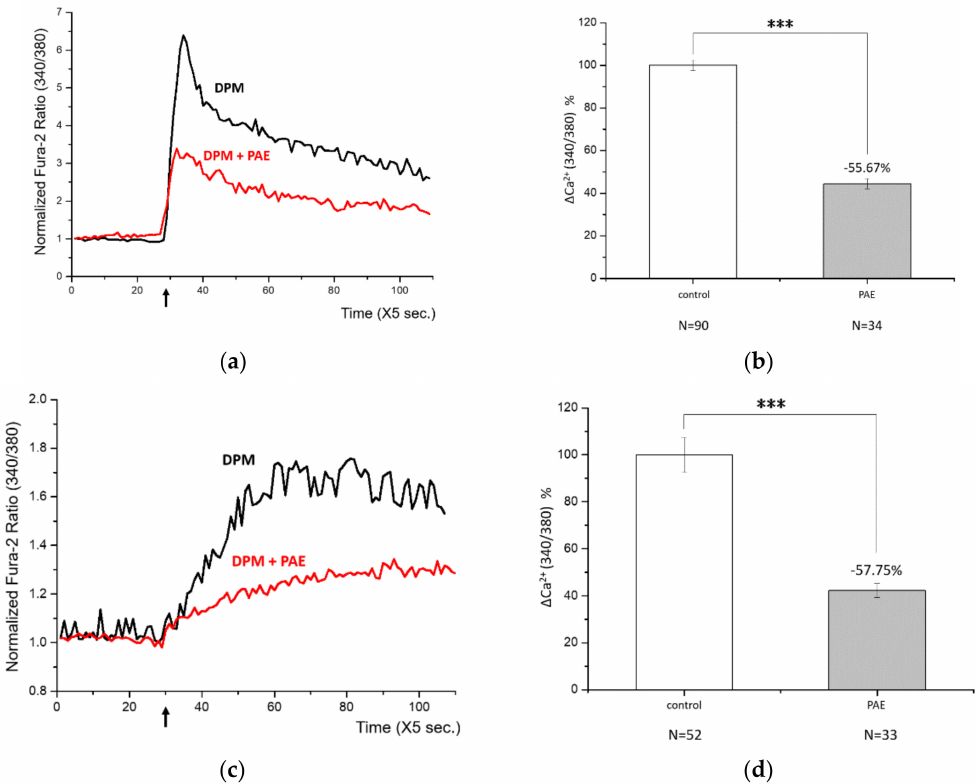
Figure 2. Phellodendron amurense bark extract (PAE) was able to reduce DPM-induced Ca 2+ influx in both HBT-SM and immortalized nontumorigenic epithelial (HaCaT) cells. ( a ) HBT-SM cells were preincubated with PAE (blue and red), or not (black), and 25 µ g/mL of DPM was treated at the indicated time (arrow). Blue and red represent independent sets of experiment. ( b ) The inhibition of Ca 2+ influx by PAE was highly significant. ( c ) The same experiment was conducted using HaCaT cells. Red, preincubated with PAE; black, not. ( d ) DPM induced similar Ca 2+ influx, which was inhibited by PAE, and the effect was also robust and significant in HaCaT cells. (*** p <